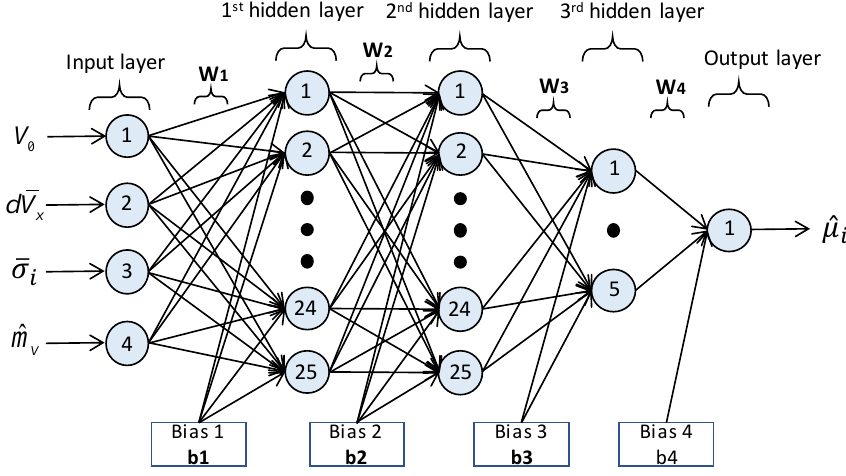
Figure 4. Proposed ANN structure (four inputs, three hidden layers, and one output).